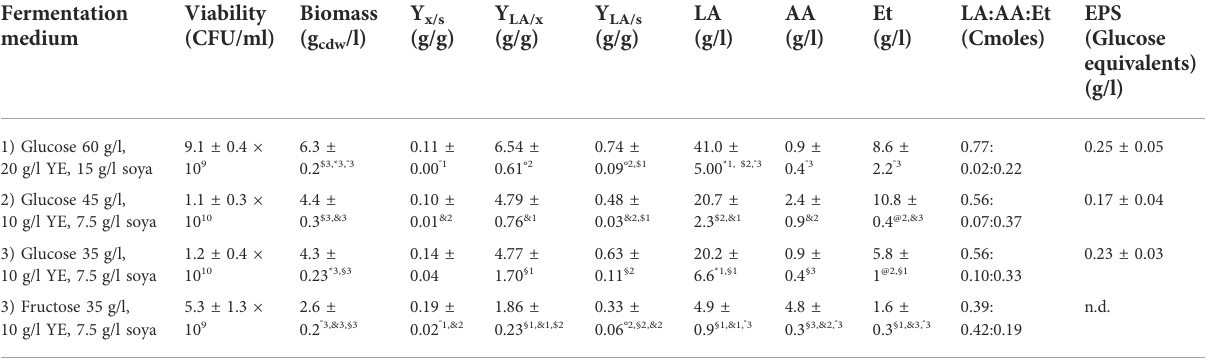
TABLE 2 Batch experiments performed on a Biostat CT plus reactor with a working volume of 2.2 l at 32 ° C, on semide fi ned medium with different carbon sources and amounts of complex nitrogen sources. n.d. not detected, below assay threshold. Mean and standard deviation were calculated from three biological replicates for each